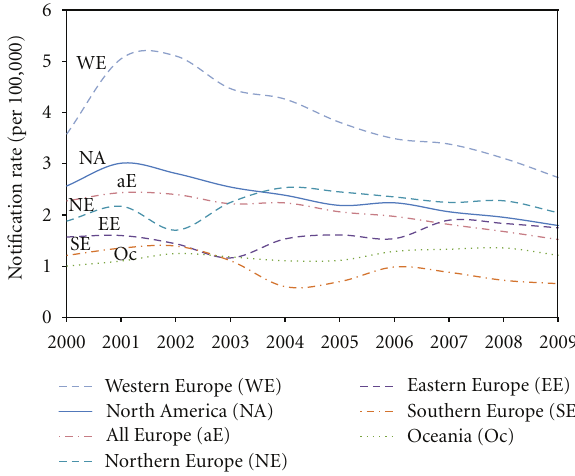
Figure 2: Line graph comparing the yearly incidence rate of yersiniosis reported for various European countries, North America, and Oceania. Surveillance data were collected from national repositories for Canada (National Microbiology Labo- ratory, http://www.publichealth.gc.ca), the United States (Food- Net, http://www.cdc.gov/foodnet), 24 European Union mem- bers (European Food Safety Authority, http://www.efsa.europa .eu), New Zealand (The Institute of Environmental Science and Research, http://www.surv.esr.cri.nz), Australia (OZFoodNet, http://www.ozfoodnet.gov.au), Northwestern Russia, the Republic of Karelia, Ukraine, and Belarus (EpiNorth Project, http://www .epinorth.org). The yearly incidence rate (cases per 100,000 in the surveillance population) was calculated based on total reported cases per year and published population figures included in published surveillance reports or governmental census sites. For countries where surveillance did not include the entire population, rates were adjusted based on the surveillance population and case information provided with the original surveillance data. For countries that did not provide data for all years included in the analysis (i.e., 2000–2009), the rate was extrapolated using linear regression (e.g., Canada, Australia, and Luxembourg). Notification rate (calculated as explained above) per 100,000 persons is shown on the ordinate , and a total of 30 countries presented by region are displayed on the abscissa . Western Europe (WE) includes Austria, Belgium, France, Germany, and Luxembourg. North America includes Canada and the United States. Northern Europe includes Latvia, Lithuania, Estonia, the United Kingdom, Ireland, Denmark, Norway, Finland, Sweden, and the Republic of Karelia. Eastern Europe includes the Czech Republic, Poland, Slovakia, Hungary, Bulgaria, the Ukraine, Belarus, and Northwestern Russia. Southern Europe includes Slovenia, Spain, and Malta. Oceania includes New Zealand and Australia. All of the available European data considered together (aE), representing a total of 28 countries, is also shown for